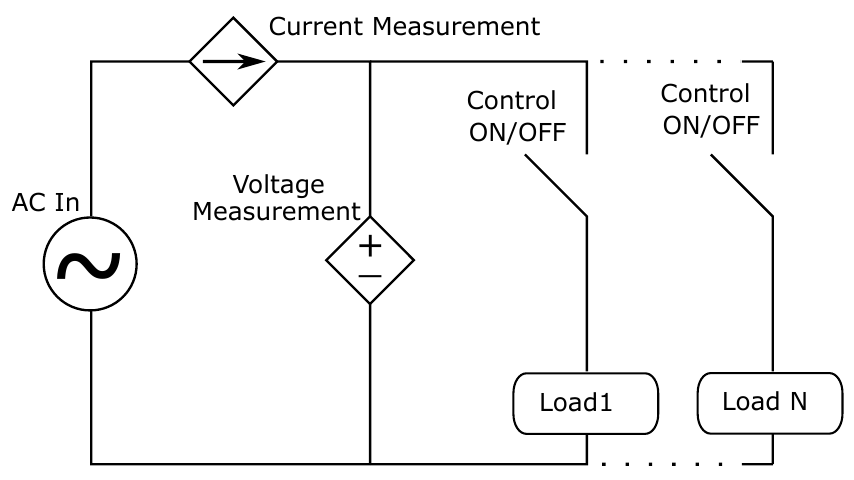
Figure 5. General diagram of the simulated subset.